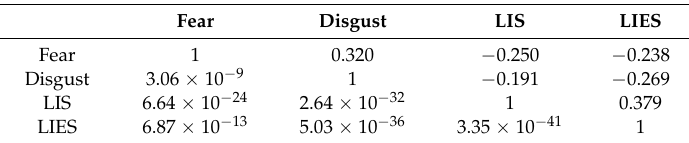
Table 2. Polychoric Correlations (Upper Triangular Region) and p -values (Lower Triangular Region) for Fear, Disgust, LIS and LIES.